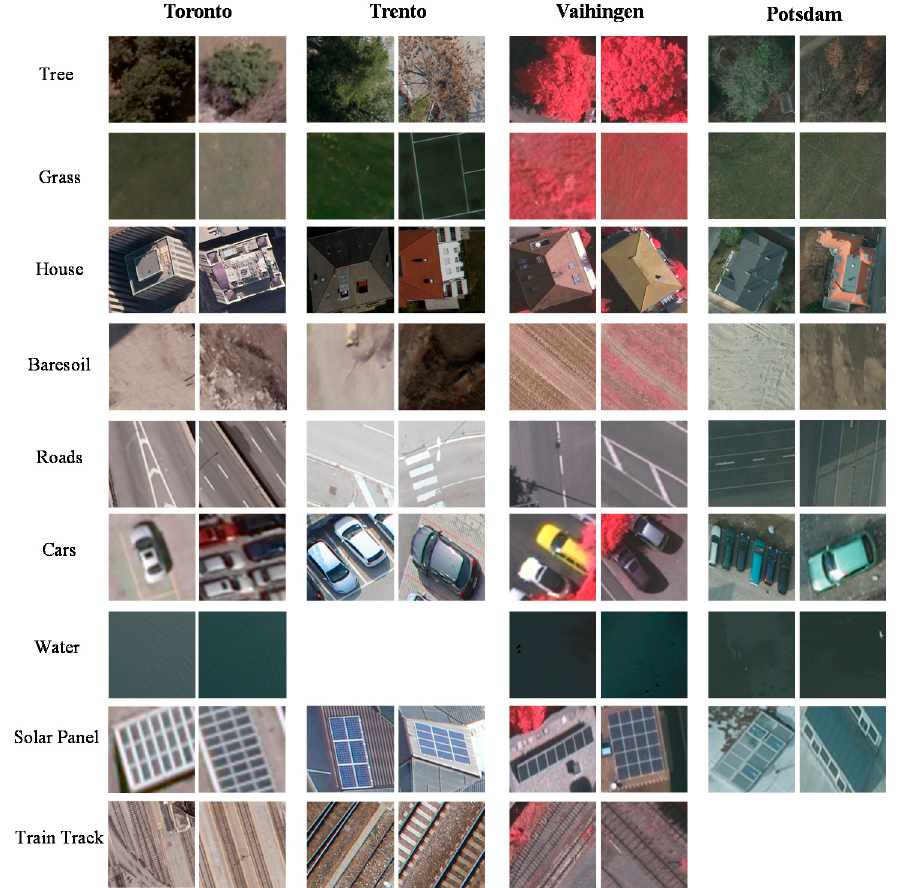
Figure 6 . Sample EHR images used in the experiments. Figure 6. Sample EHR images used in the